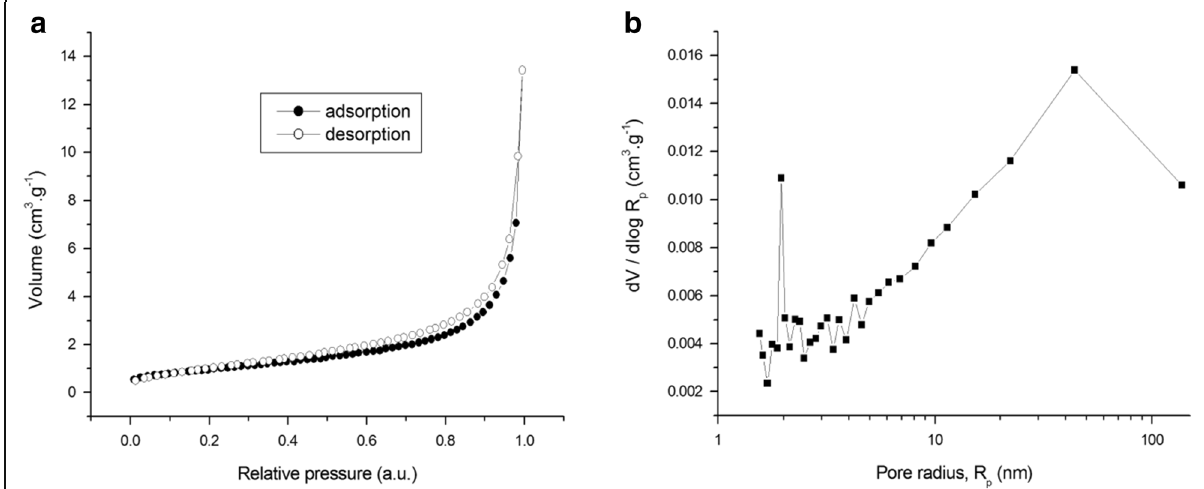
Fig. 4 Surface properties of the CFTS sample. a Nitrogen adsorption/desorption isotherm. b Pore size